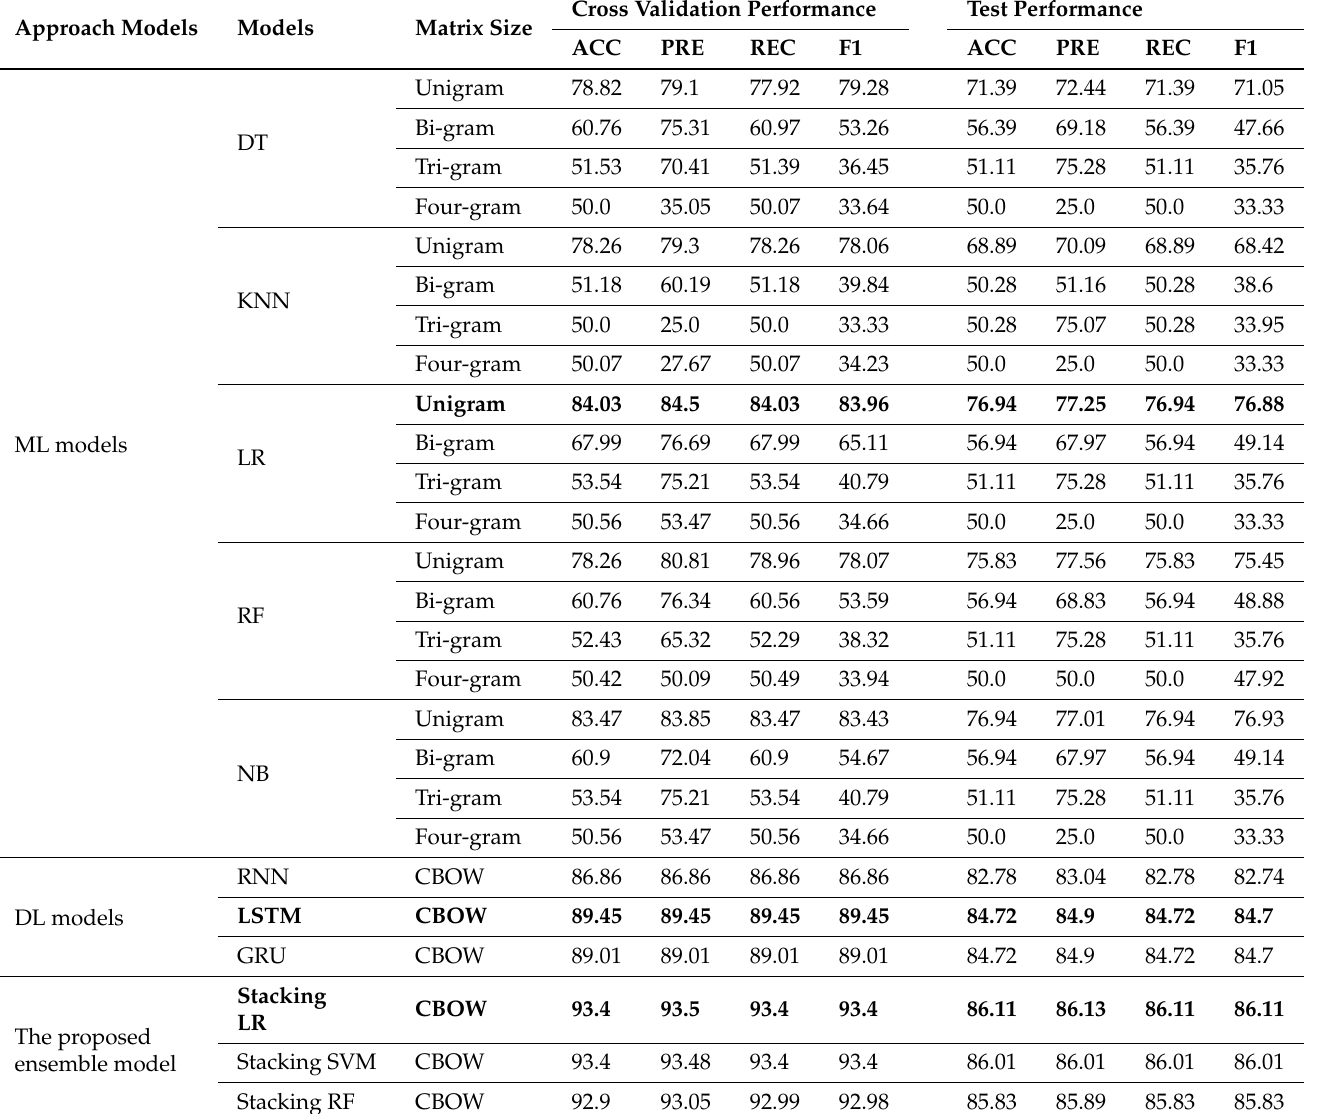
Table 4. The performance results of ML, DL, and the proposed models for AJGT